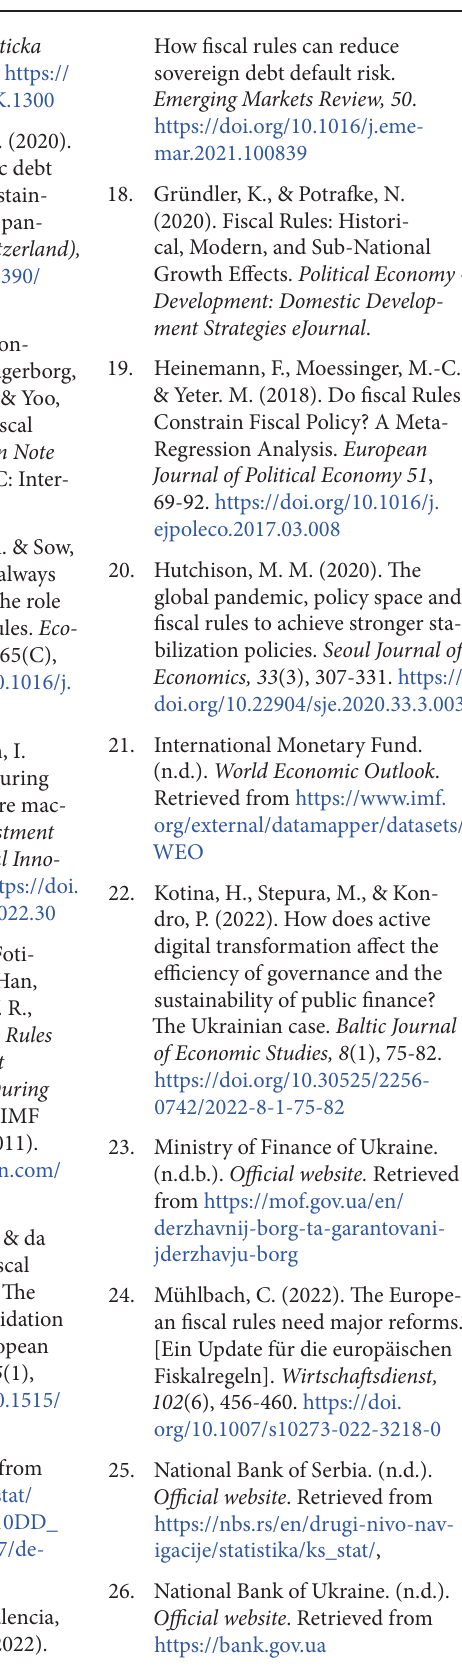
Official website . Retrieved from